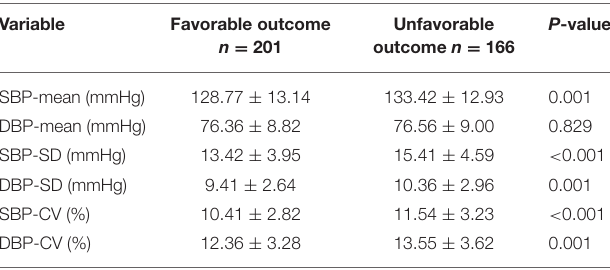
TABLE 3 | Comparison of SBP and DBP profiles between patients with favorable and unfavorable